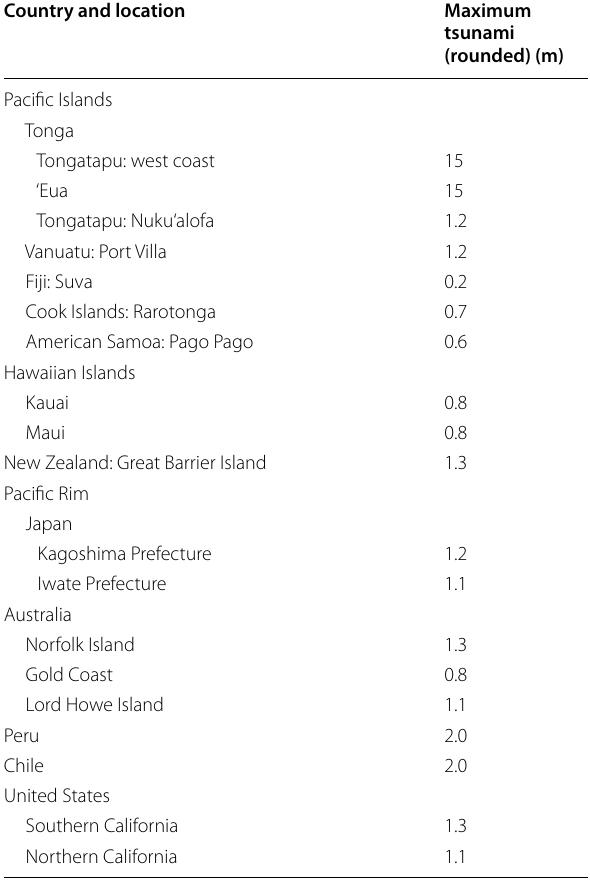
Data sources: Risk Frontiers (2022a), field observations and various internet sources (unverified)